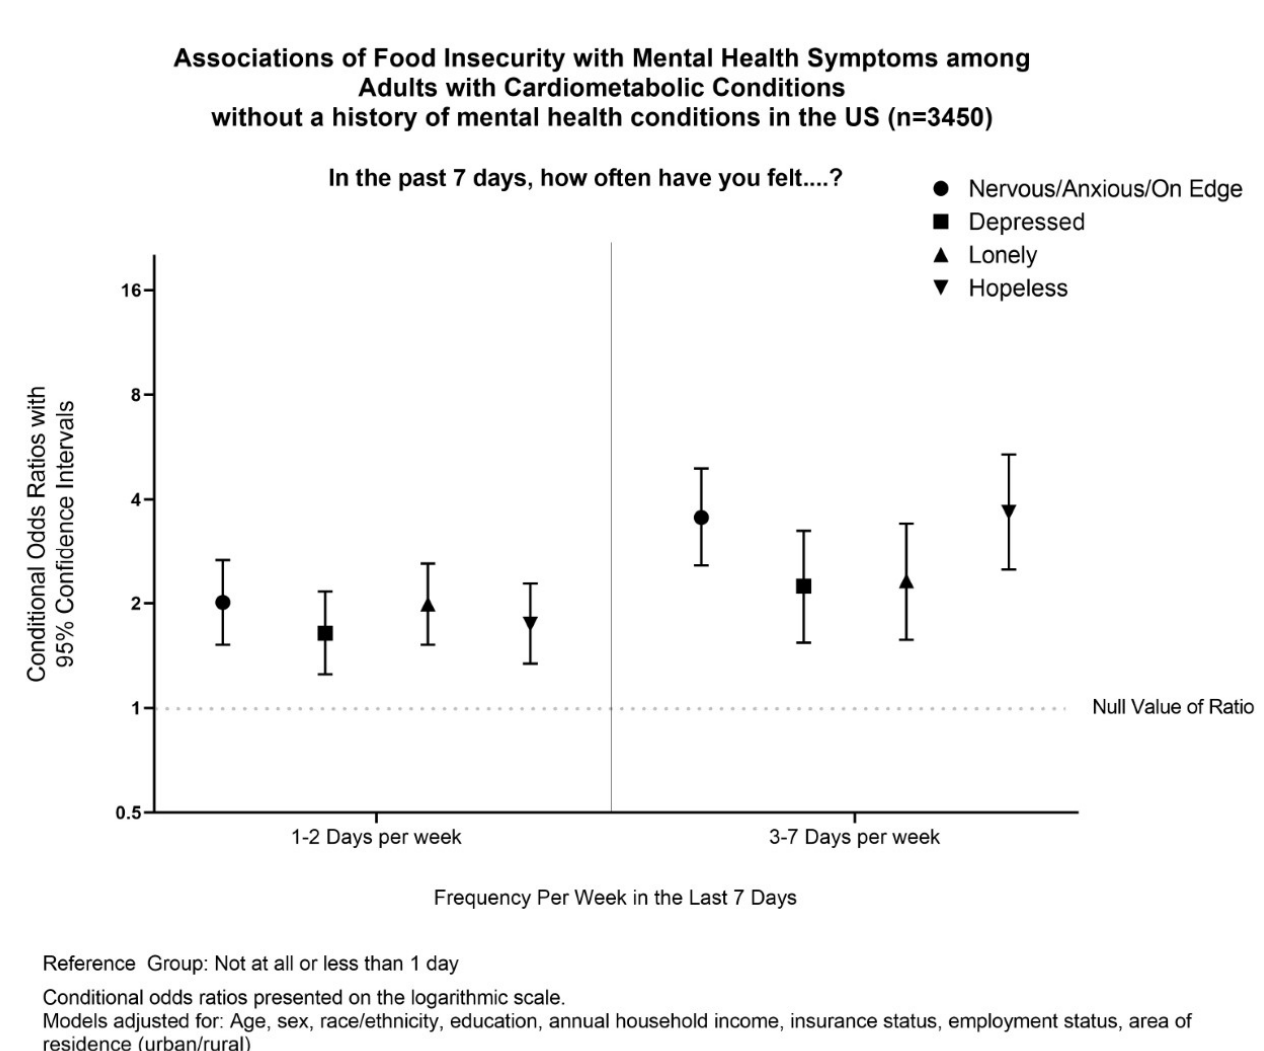
Figure 1. Associations of Food Insecurity with Mental Health symptoms among Adults with Cardiometabolic Conditions without a history of mental health in the US ( n = 3450).